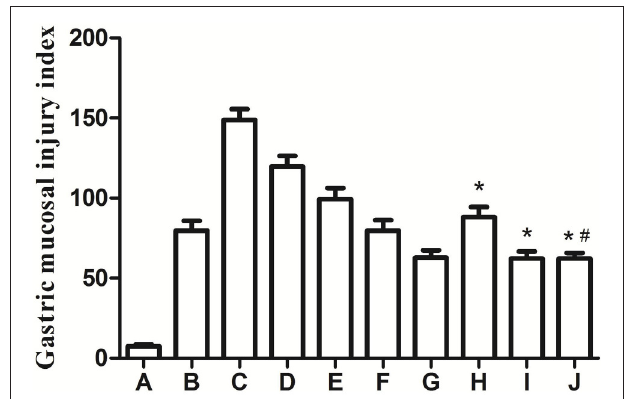
FIGURE 1 | Effects of different doses of Baclofen and different reperfusion time points on gastric injury. * P < 0.001, as compared with the GI-R (1 h) group (C), # P > 0.05, as compared with the LHA + GI-R + Baclofen group (0.5 µ g, H). A, Normal group; B, GI-R group; C, GI-R (1 h) group; D, GI-R (2 h) group; E, GI-R (4 h) group; F, GI-R (8 h) group; G, GI-R (16 h) group; H, LHA + GI-R + 0.5 µ g Baclofen group; I, LHA + GI-R + 1.5 µ g Baclofen group; J, LHA + GI-R + 3.0 µ g. n = 6.